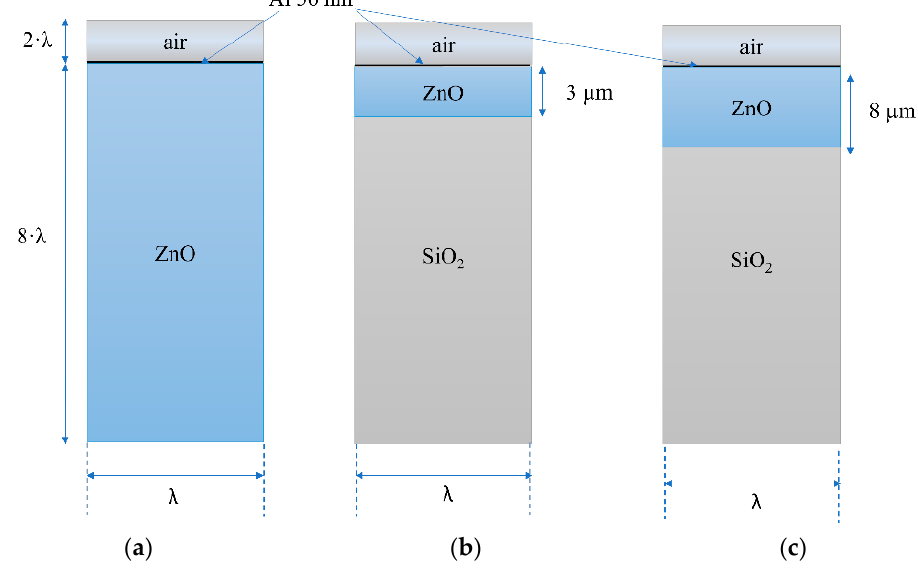
Figure 3. The unit cell made of ( a ) air/Al (50 nm)/ZnO half-space; ( b ) air/Al (50 nm)/ZnO (3 µm)/SiO 2 half-space; ( c ) air/Al (50 nm)/ZnO (8 µm)/SiO 2 half-space. The picture is not in